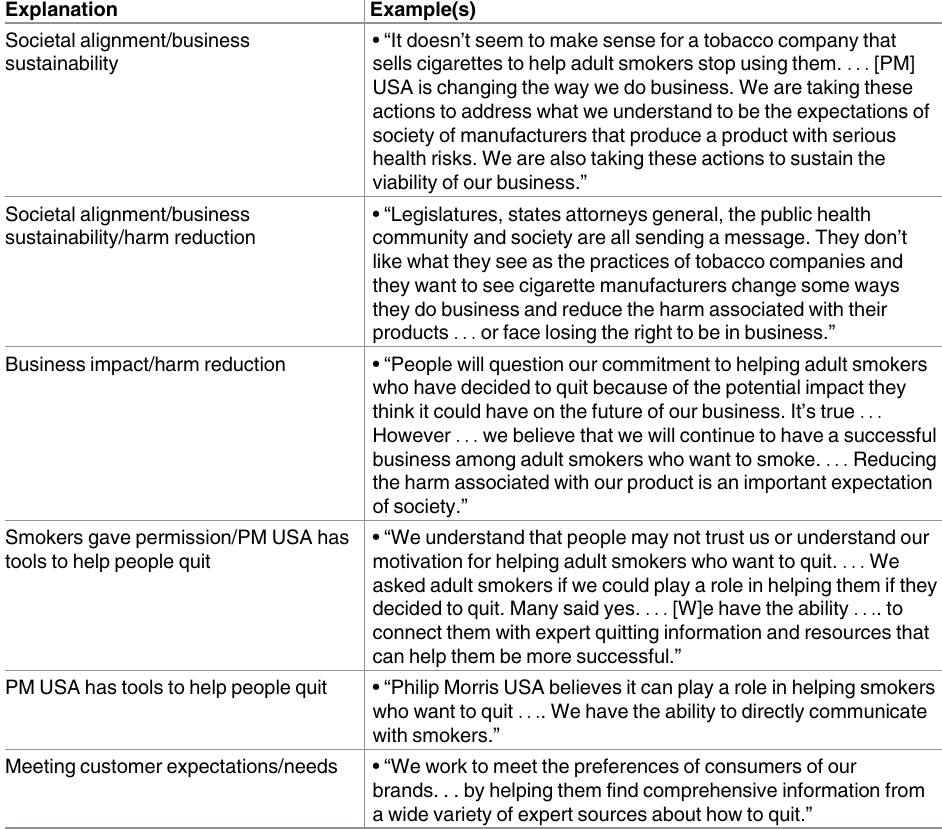
Table 2. Philip Morris USA focus group-tested explanations for its involvement in smoking cessation, 2003